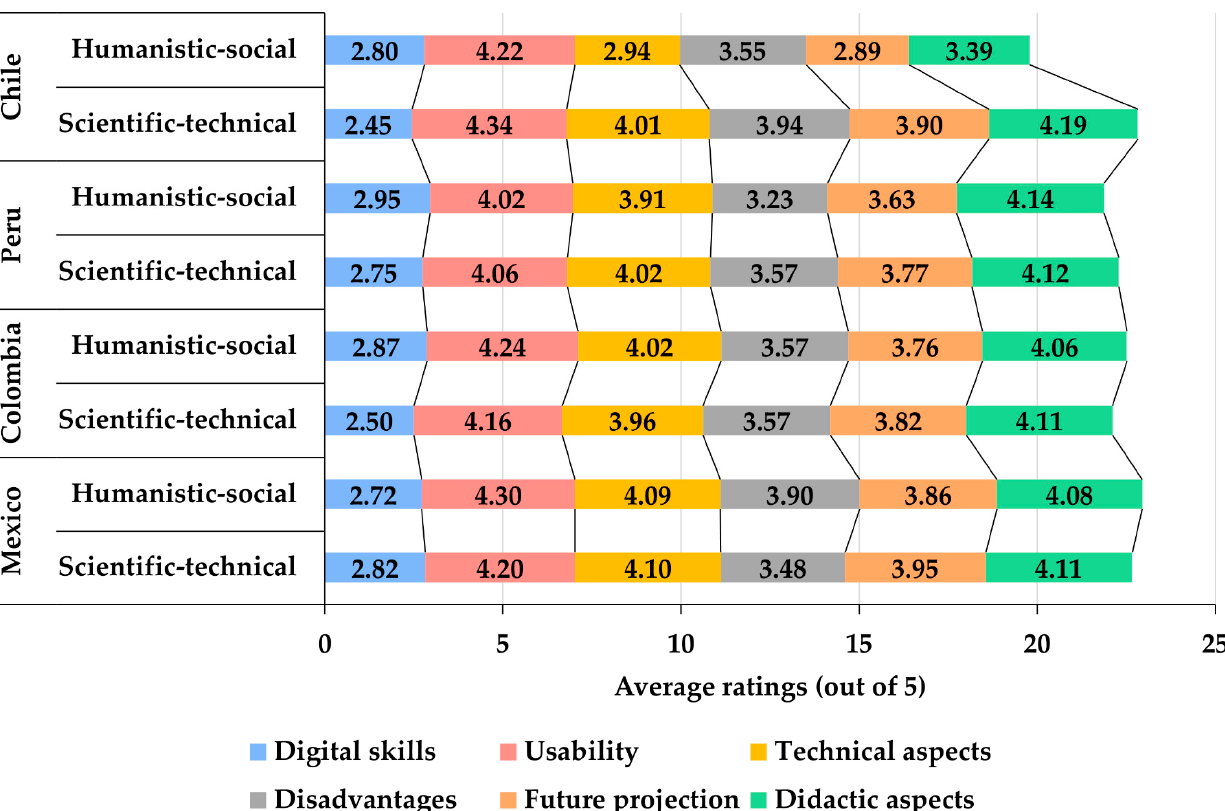
Figure 4. Average responses (out of 5) differentiating by country and knowledge area.